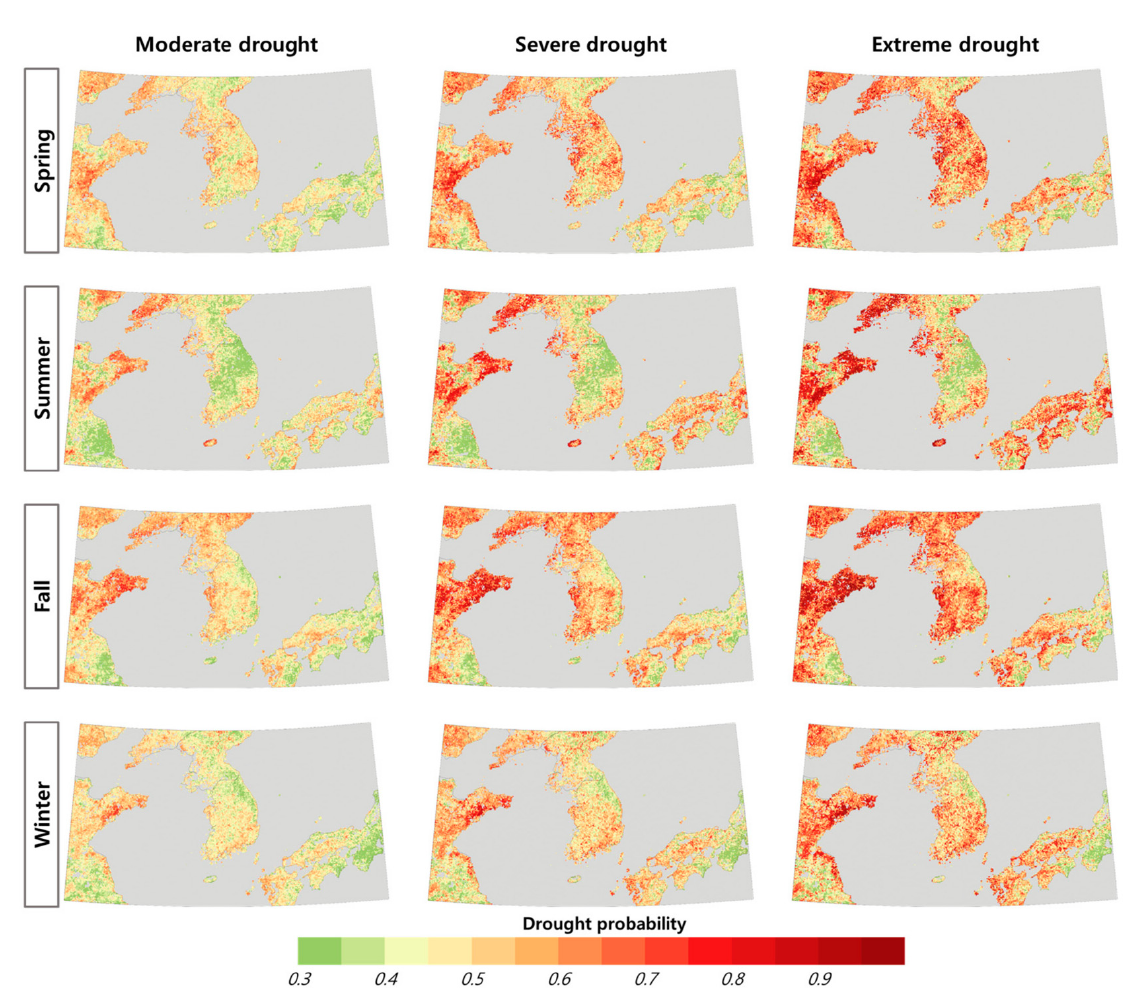
Figure 9. Vegetation drought vulnerability map for VHI threshold ( u VHI ≤ 0.3) under atmospheric water supply deficit